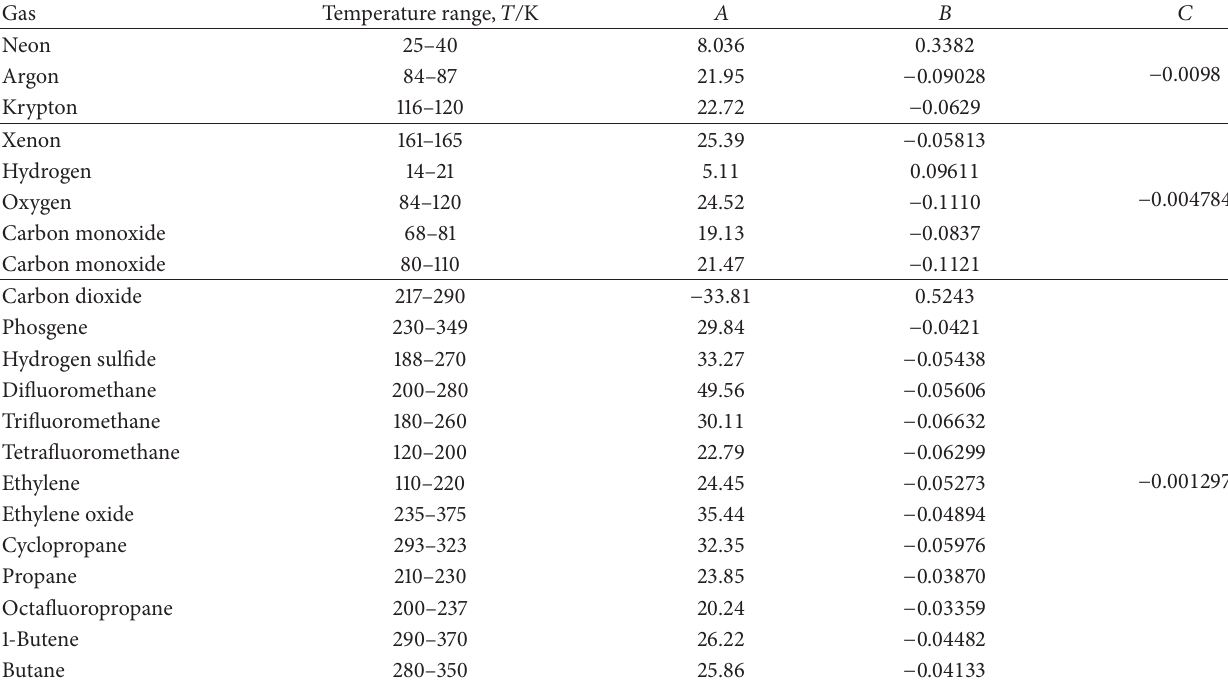
Table3:Thetemperaturedependenceofthesolubilityparametersofgaseoussolutes, 𝛿 H /MPa 1/2 = 𝐴+𝐵(𝑇/ K )+𝐶(𝑇/ K ) 2